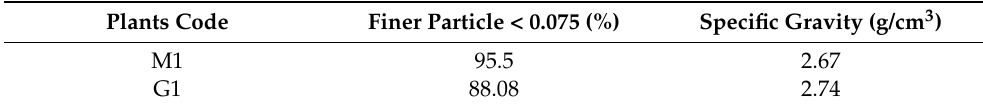
Table 5. Specific gravity and percentage of finer particles for the two sludge. Plants